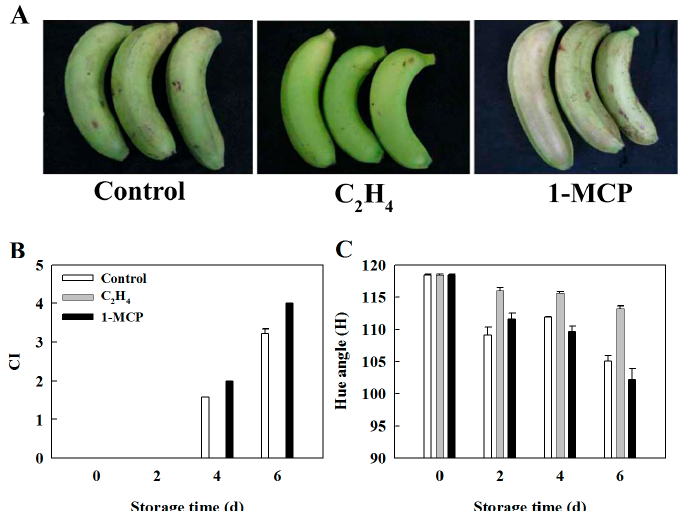
Figure 4. Visual appearance and physiological characterization of banana fruit stored at 6°C. Visual appearance ( A ) of banana fruit treated with ethylene and 1-MCP for 12 h after 6 days of storage at 6 °C. Effect of ethylene and 1-MCP pretreatments on chilling injury ( B ) and color parameter ( C ) of banana fruit stored at 6 °C. The hue angle of 120 means green color while 90 means yellow color.